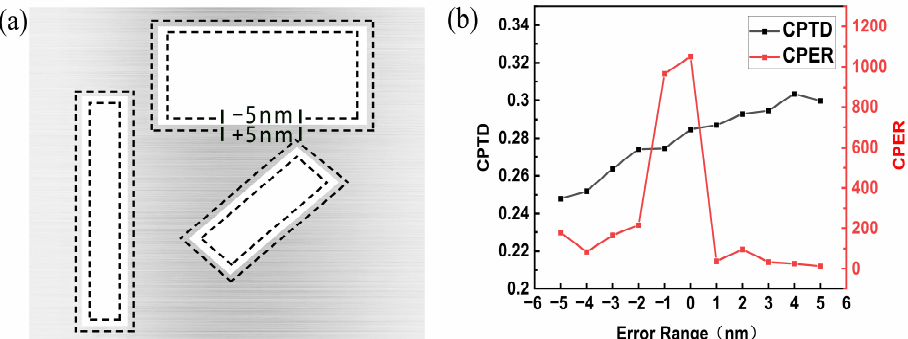
Figure 11. ( a ) Schematic diagram of the basic cell structure with the ± 5 nm dimensional error range. ( b ) Simulated optical properties of the SCPMs with the dimensional error of the rectangular slots.